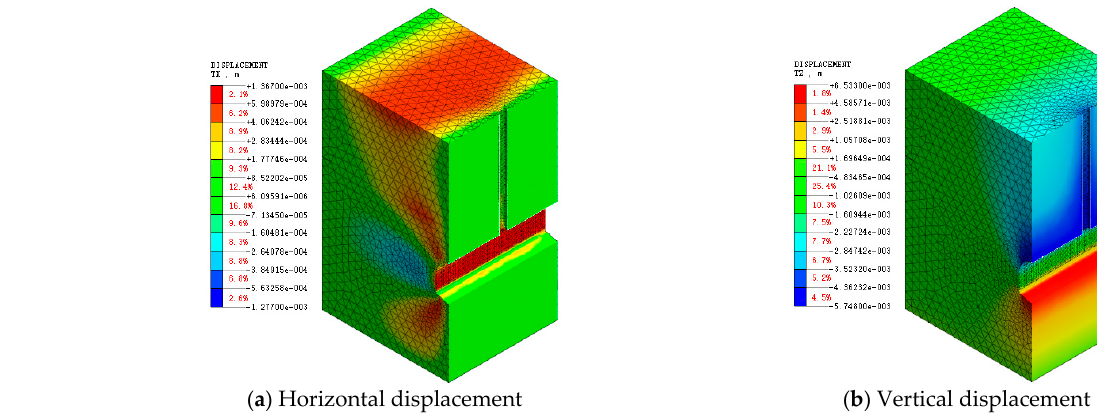
Figure 13 is the displacement cloud map after the tunnel expansion was completed. After the expansion of the tunnel, the surrounding rock as a whole showed intrusive deformation into the tunnel. The vertical displacement was greater than the horizontal displacement. The maximum horizontal displacement was 1.36 mm, and the maximum vertical displacement was − 5.74 mm. Both the maximum horizontal displacement and the maximum vertical displacement were located in monitoring section C.